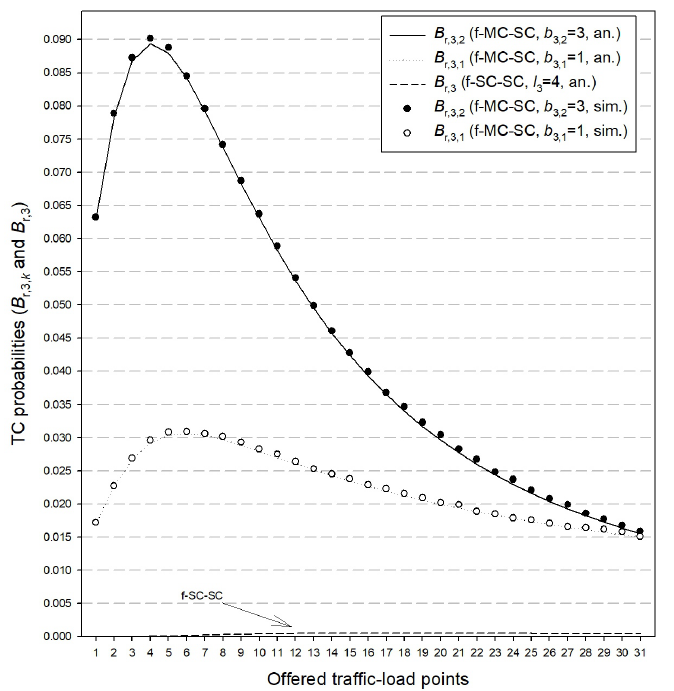
Figure 6. TC probabilities as the result of RRUs unavailability (3rd